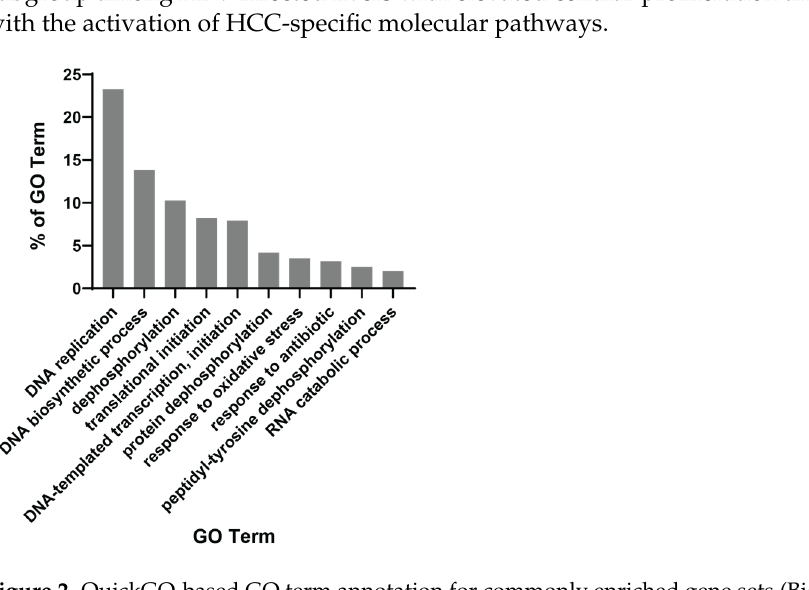
Figure 2. QuickGO ‐ based GO term annotation for commonly enriched gene sets (Biological Process) Figure 2. QuickGO-based GO term annotation for commonly enriched gene sets (Biological Process) in PCM1 ‐ U group. in PCM1-U